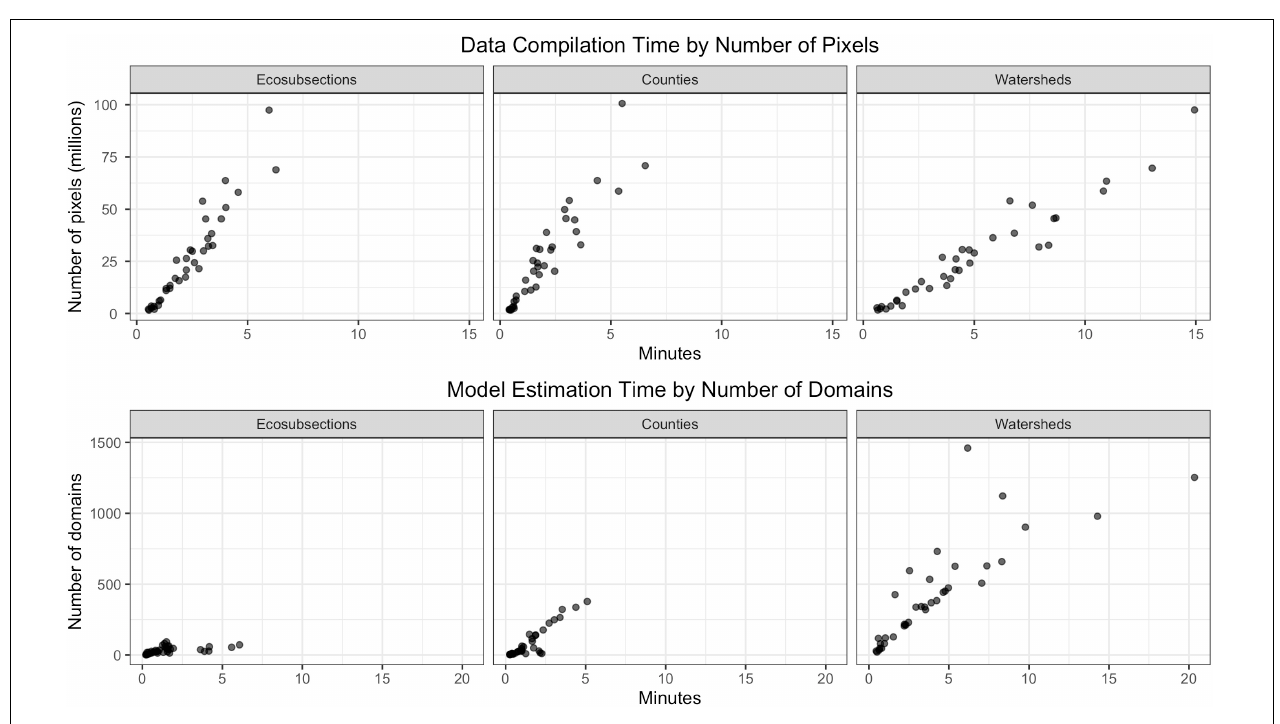
FIGURE 3 | Nationwide processing times for data summarization and model estimation. Times are expressed in minutes by number of domains and number of pixels for each of the national datasets: ecosubsections, counties, and